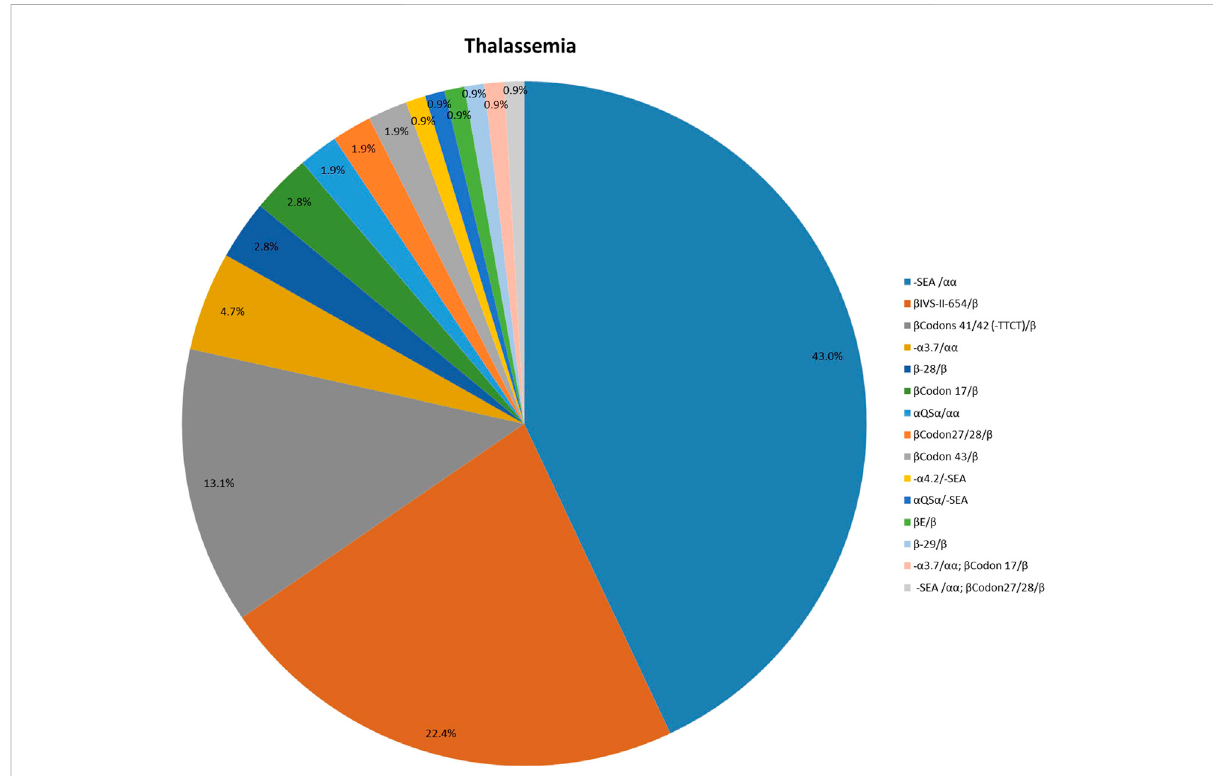
FIGURE 2 ThedistributionofmoleculargeneticsspectrumofthalassemiaamongbreastcancerpatientsinJiangxiprovince.The- SEA / αα , β IVS − II − 654 / β , β Codons 41/42 / β , - α 3.7 / αα , β − 28 / β and β Codon17 / β were the top six common genotypes with frequencies of 43.0%, 22.4%, 13.1%, 4.7%, 2.8%, and 2.8%,